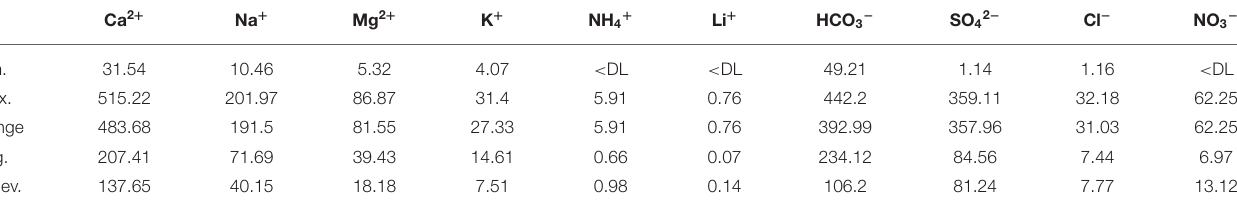
TABLE 1 | Summary of results from ion analysis; all concentrations expressed in µ Eq/L; < DL indicates concentration was below instrument detection limit.